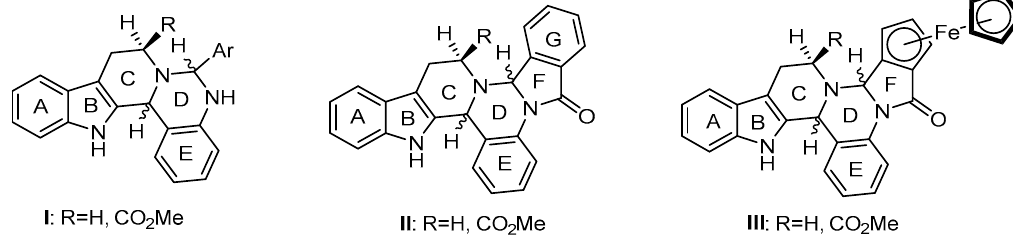
Figure 1. Three types of the targeted polycyclic β -carbolines with diverse streostructures derived from tryptamin (R = H) and L -tryptophan (R = CO 2 Me).